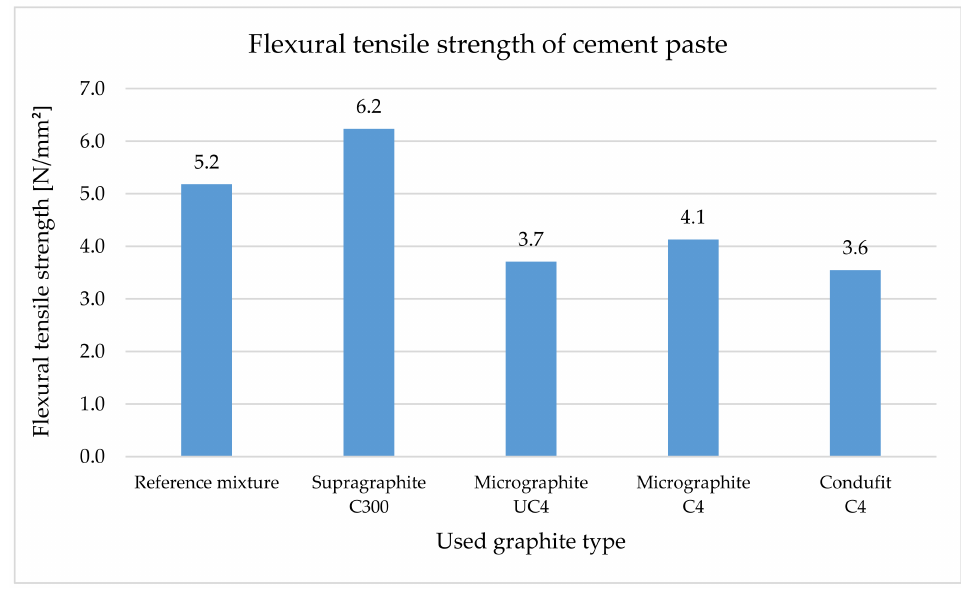
Figure 12. Flexural tensile strength of cement paste.